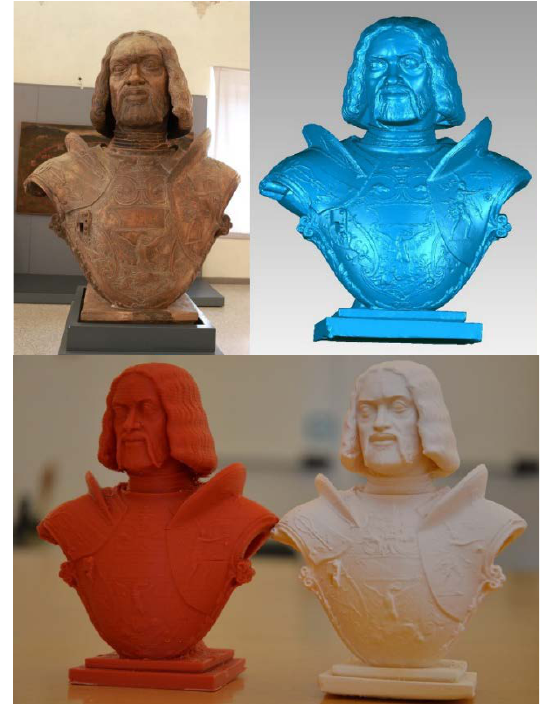
Figure 5. Digitization of the terracotta bust of Francesco II Gonzaga, in the City Museum of Mantua: the original bust, its digital reproduction and two physical